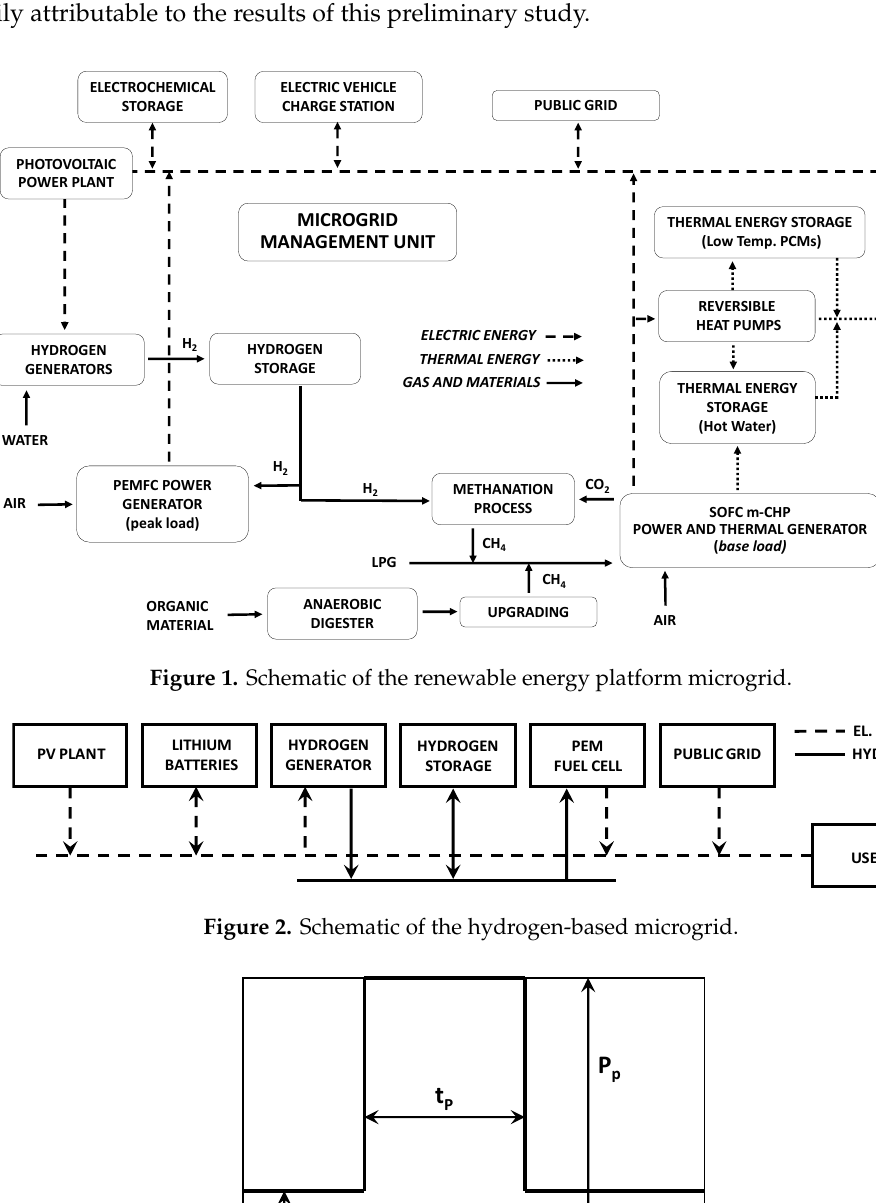
Figure 2. Schematic of the hydrogen-based microgrid.